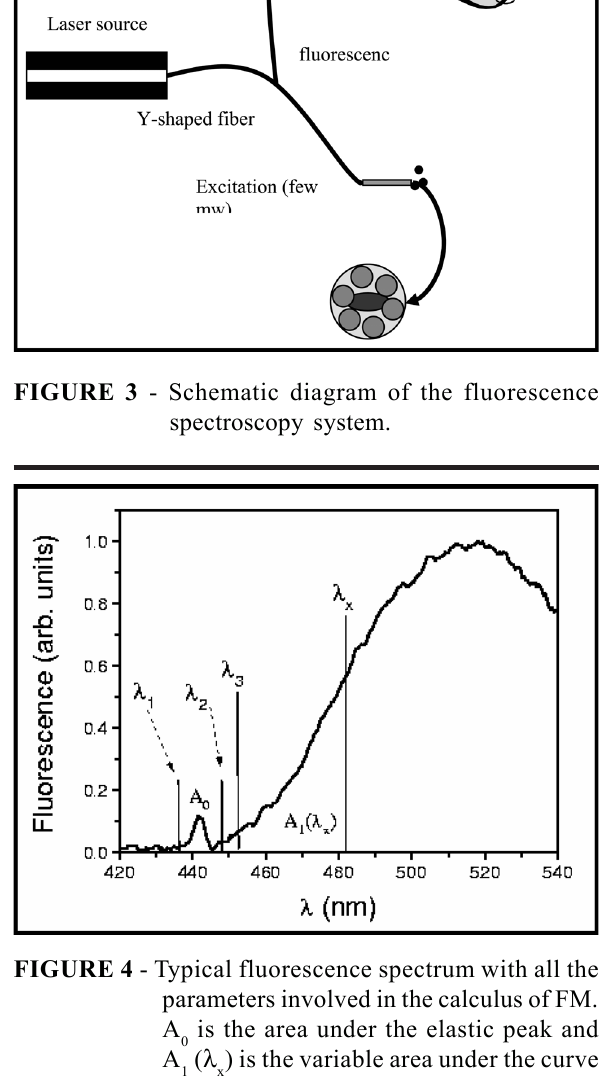
FIGURE 5 - The figure of merit as a λ (nm) function of the upper limit wavelength λ of the integral A (x) x 1 for excitation at (a) 443 nm and (b) 532 nm respectively. The solid squares are data for the normal liver and the open circles for the hepatocarcinoma.